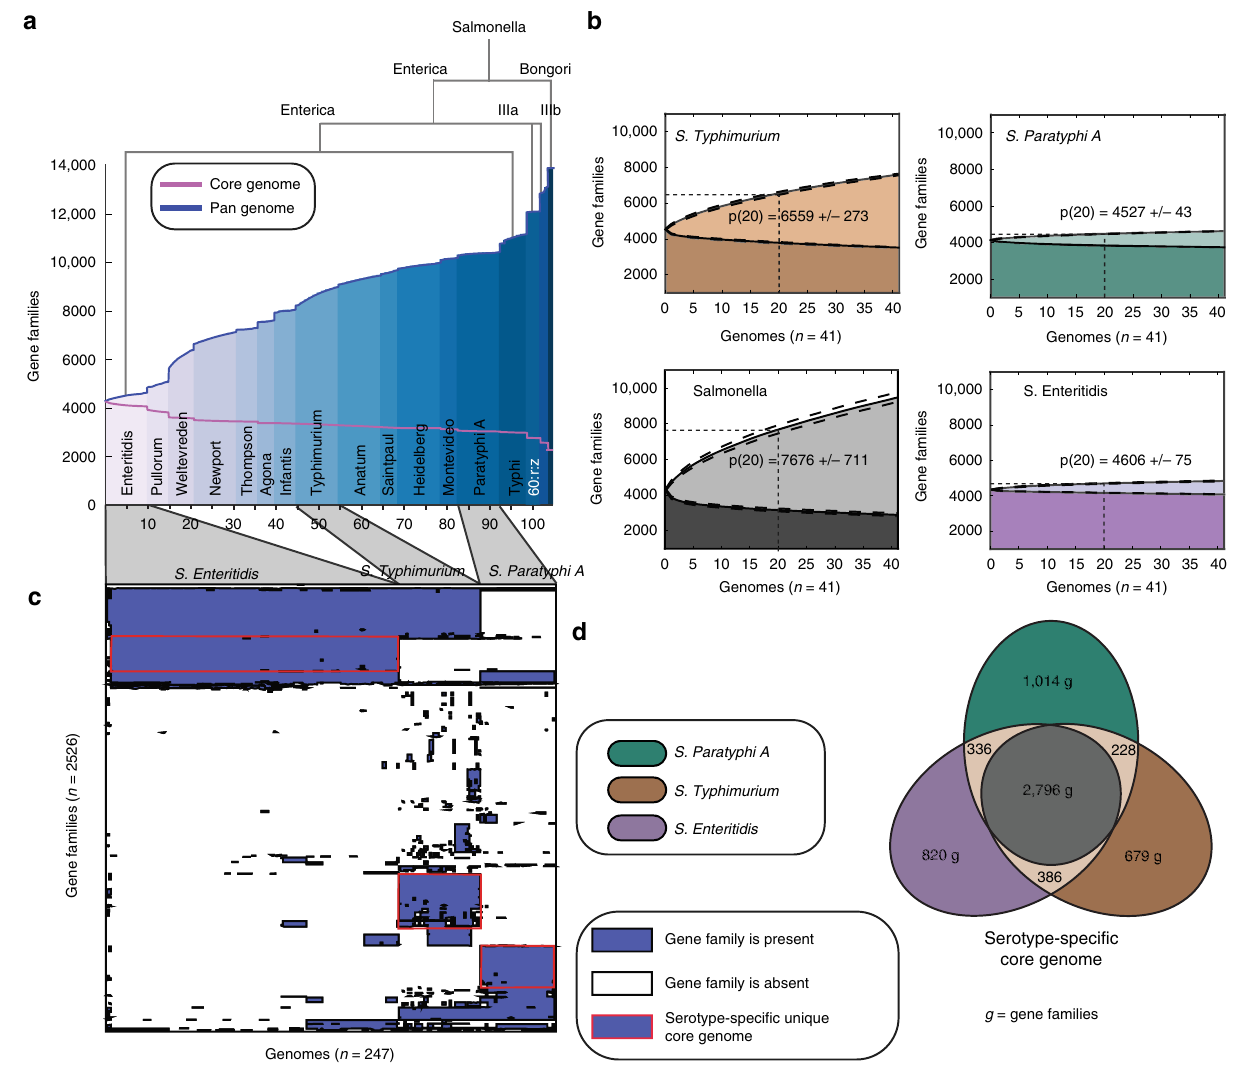
Fig. 1 Core and pan-genomes of Salmonella serovars. a The Salmonella pan-genome was constructed for 104 out of 410 genomic sequences of Salmonella , including 2 species; S. enterica and S. bongori , 3 subspecies; S. enterica spp . enterica, S. enterica spp . IIIA, S. enterica spp . IIIB . For purposes of clarity, the serovars of S. enterica spp . enterica are represented in black when 3 or more corresponding genomes are available with a maximum of 10 randomly sampled genomes per serovar. See Supplementary Fig. 3 for the full Salmonella pan-genome. Note that branch widths do not correspond to phylogenetic distances. b Serovar-speci fi c core and pan-genome curves for 41 genomic sequences of Salmonella enterica spp . enterica : Typhimurium (broad host range), Paratyphi A (host-restricted) and Enteritidis (broad host range) in comparison with 41 genomic sequences of randomly sampled Salmonella genomes. We show the average and standard deviation of the number of gene families at the 20th genomic addition (p(20)). c Cluster map of the accessory genome of Typhimurium, Paratyphi A, and Enteritidis. The gene families that are unique to a serovar and conserved across strains in that serovar are framed in red. d We identi fi ed the serovar-speci fi c core gene families for serovars Paratyphi A, Typhimurium, and Enteritidis and plotted a venn diagram to represent the shared content. Paratyphi A has the highest number of core gene families, of which 1,014 are not part of the Typhimurium nor the Enteritidis core